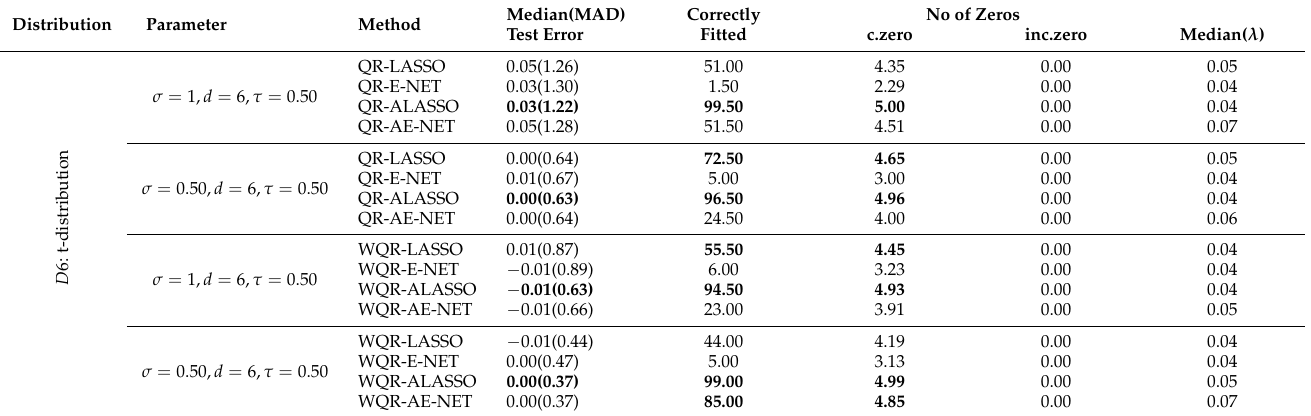
Table A5. Penalized weighted and unweighted quantile regression at D 6 under the heavy tailed t-distribution for n = 50 ( τ =